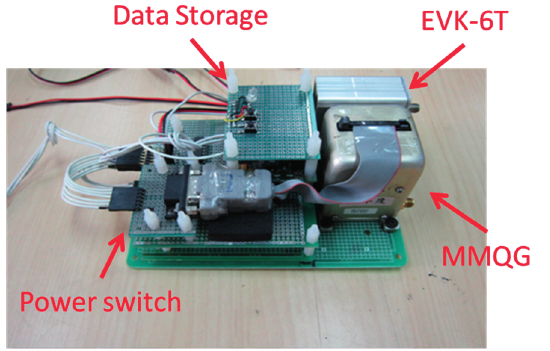
Figure 1. The DG module